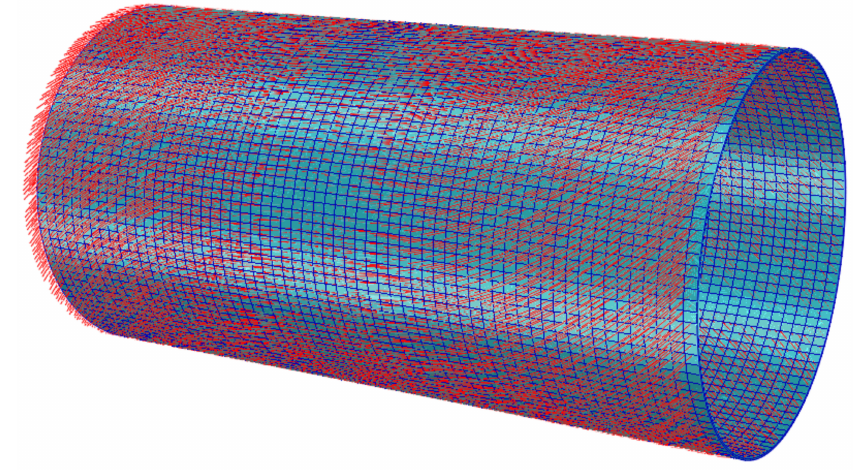
Figure 5. Finite element model of